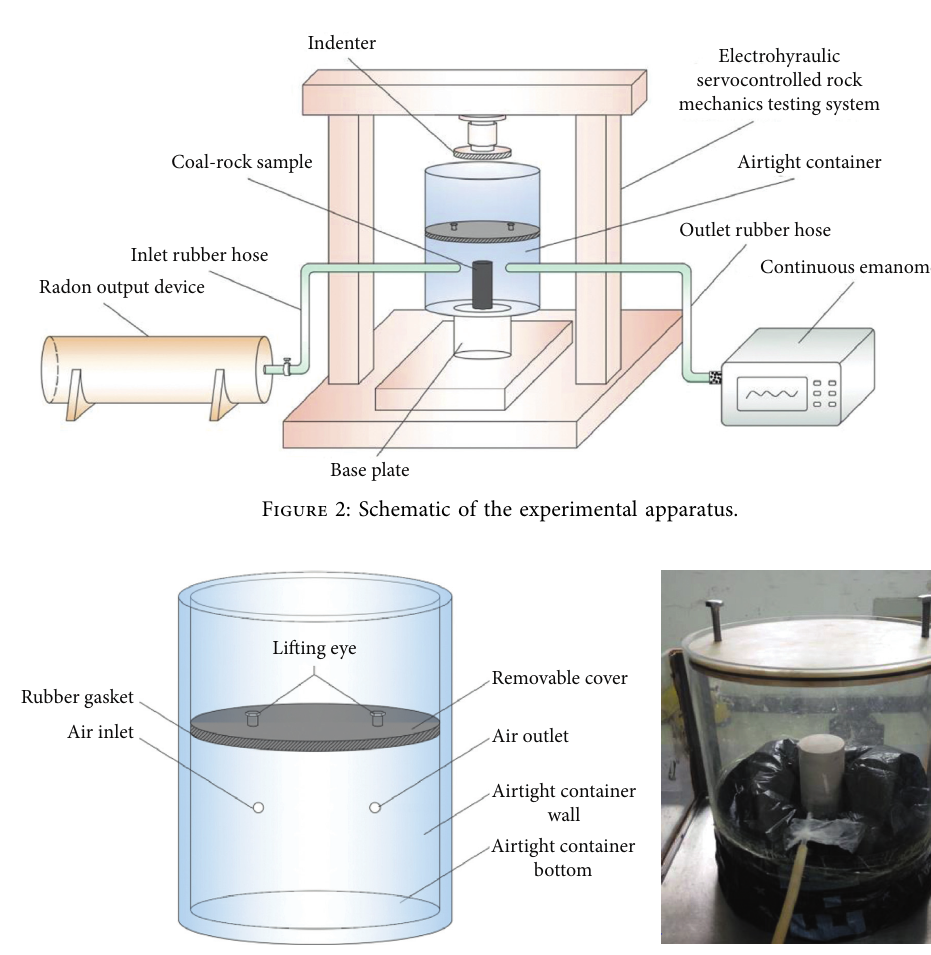
Figure 1: The microrelease process of radon atoms.